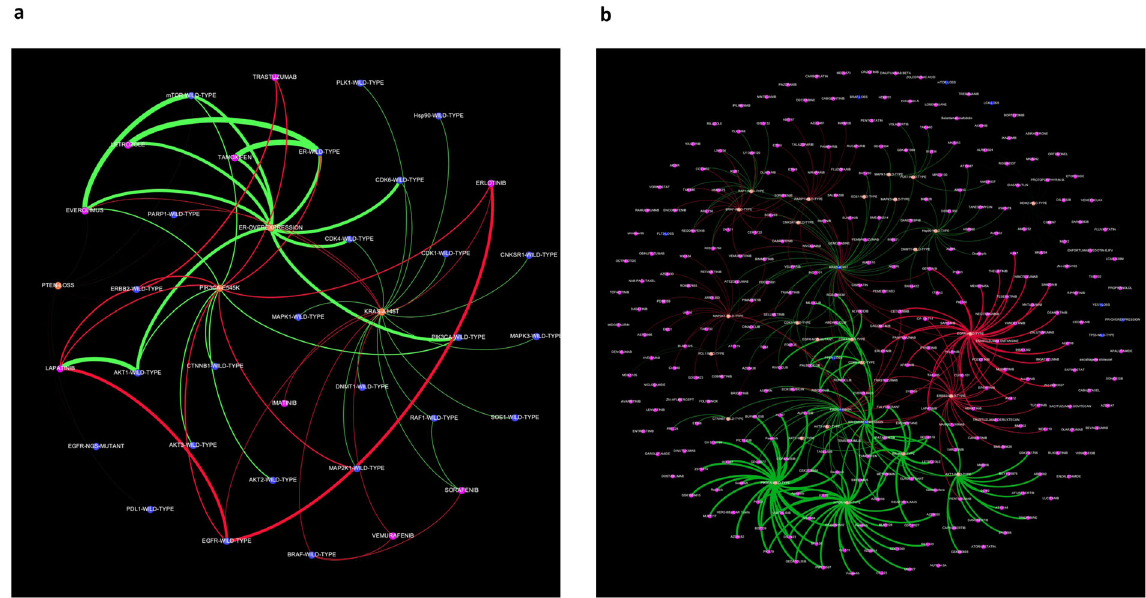
Fig. 2 Network model of a real case from SHIVA01 analyzed by the digital drug-assignment (DDA) system. This drawing presents how drivers, targets, and MTAs are connected in the digital drug-assignment system in the case of patient “ Example 5 ” (Tables 1 and 2 and Supplementary Table 2). Panel a depicts the connections of the 11 MTAs used in SHIVA01 to the drivers and targets in case of patient “ Example 5 ” . Panel b depicts the connections of all MTAs in the database of the computational system to the drivers and targets in case of patient “ Example 5 ” .